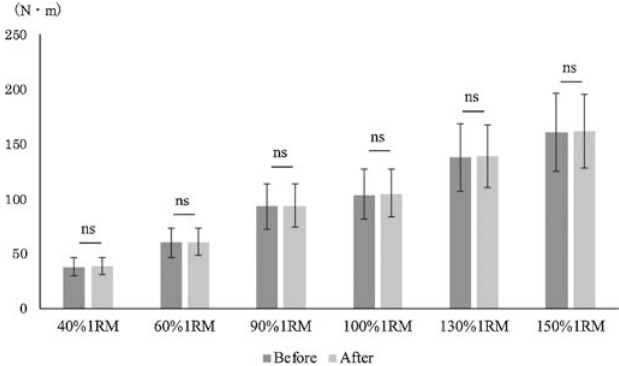
Figure 3 Comparison of average torque before and after modification of the leg extension machine. Mann-Whitney U test. *p<0.05 There was no significant difference in average torque before versus